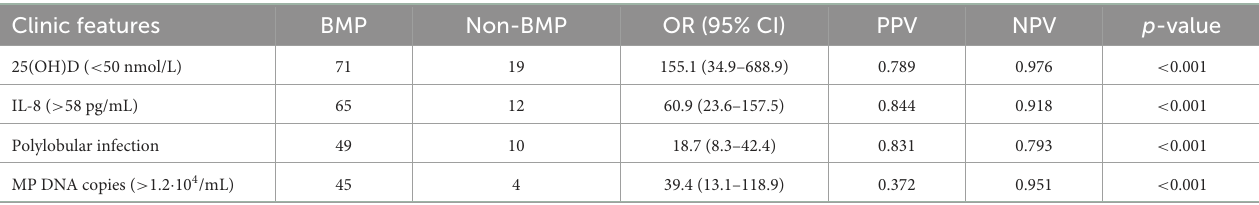
TABLE 4 PPV and NPV of independent clinical characteristics for BMPs in children with MPP.